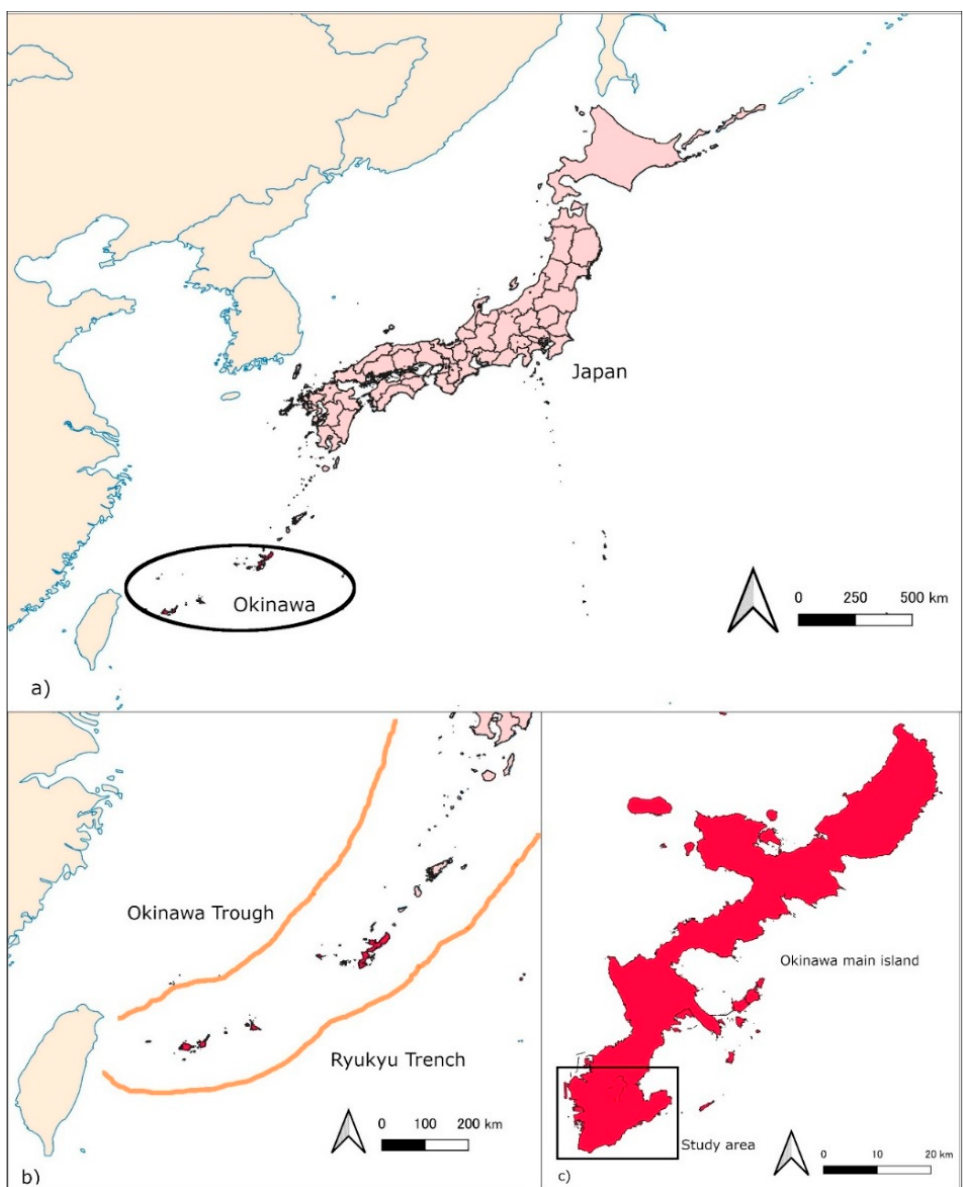
Figure 1. a: locations of the Okinawa Prefecture; b: the Ryukyu Trench; c: the southern area of the Figure 1. ( a ): locations of the Okinawa Prefecture; ( b ): the Ryukyu Trench; ( c ): the southern area of main island in Okinawa Prefecture. the main island in Okinawa